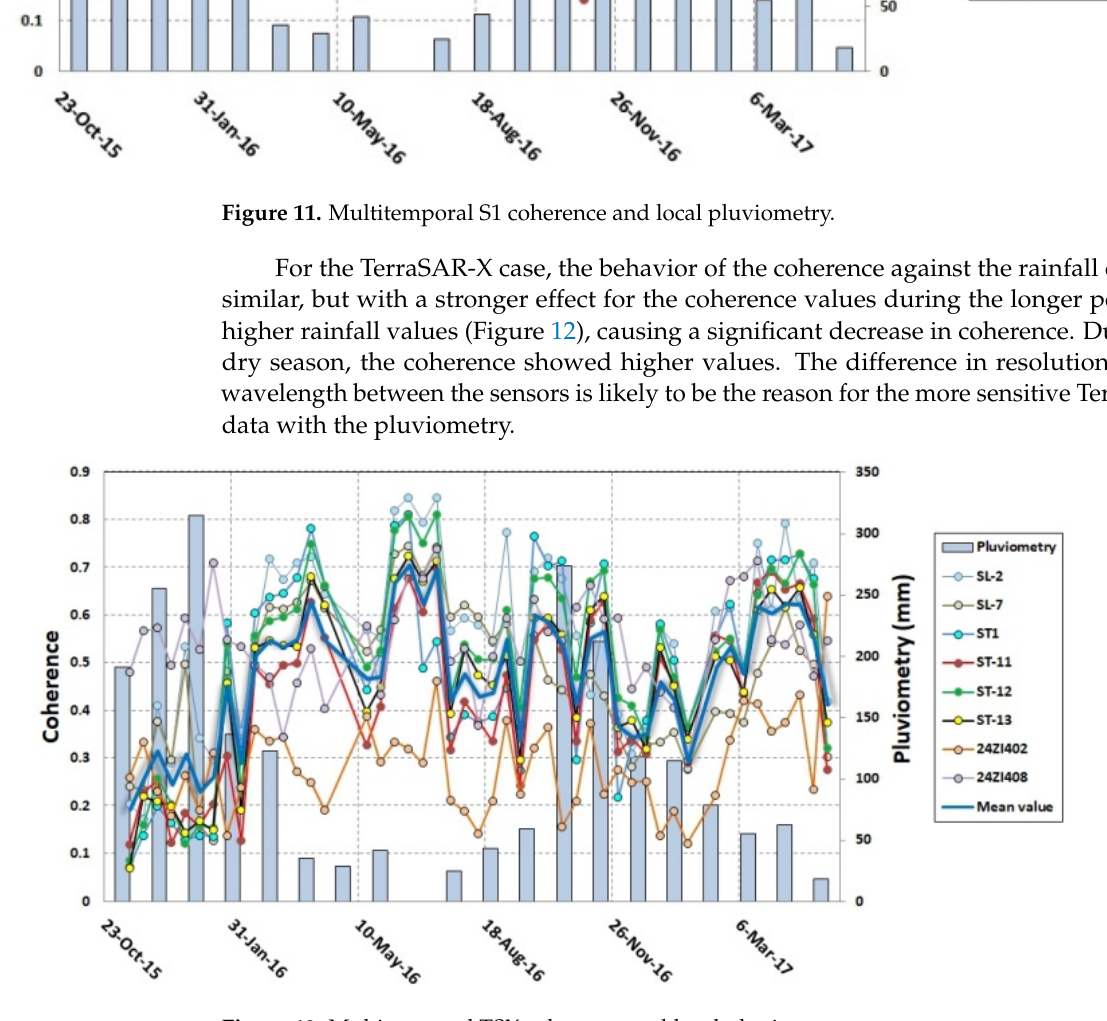
Figure 11. Multitemporal S1 coherence and local pluviometry.